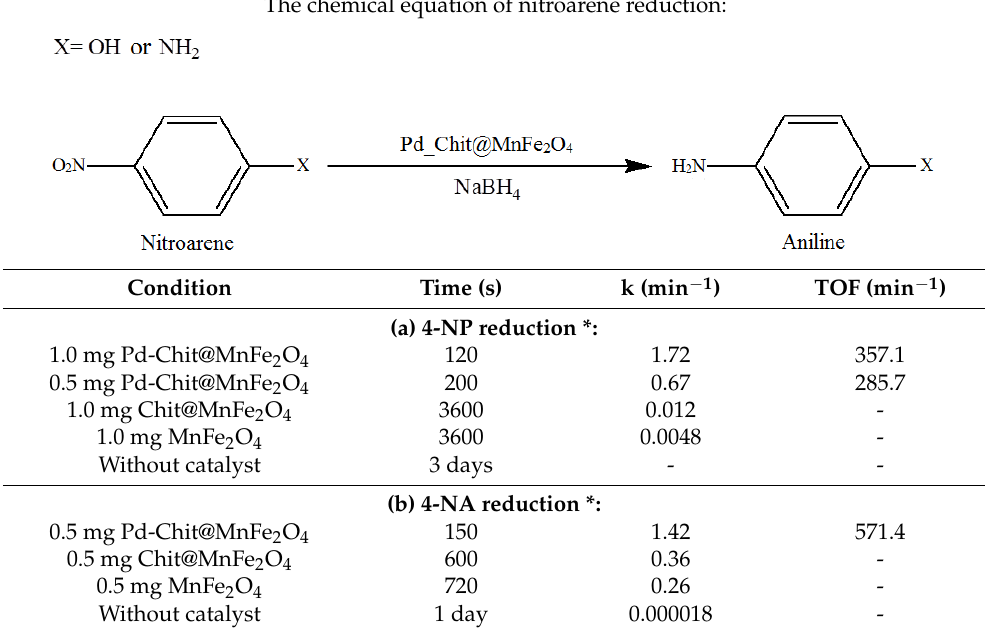
Table 3. The chemical equation and comparison of catalytic performance of Pd − Chit@MnFe2O4 for the 4-NP and 4-NA reduction in various experimental conditions. The chemical equation of nitroarene reduction: